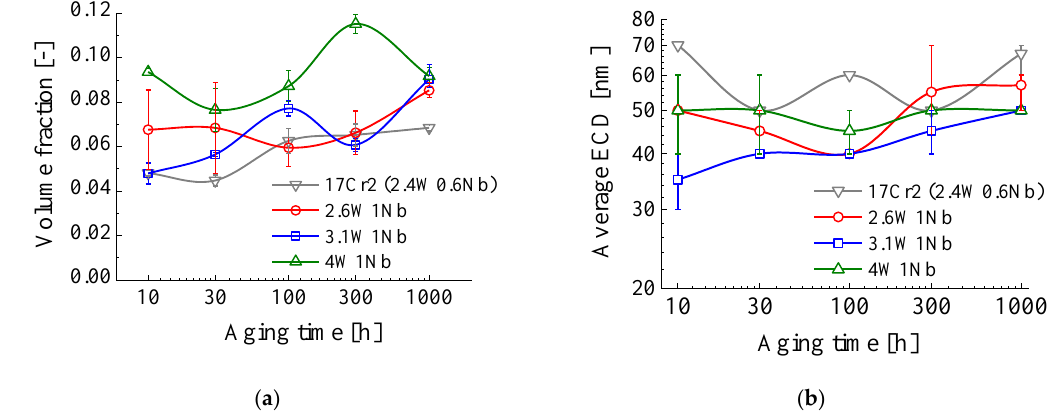
Figure 3. Evolution analysis during annealing at 650 °C: ( a ) volume fraction evolution; ( b ) average equivalent circle diameter (ECD) evolution.